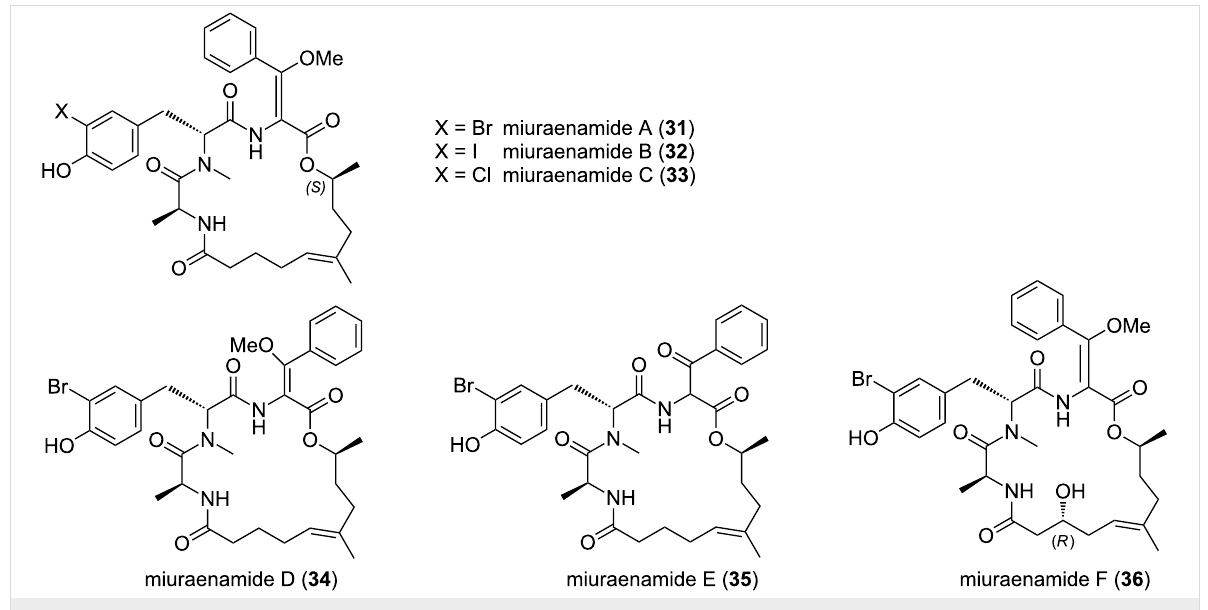
Figure 13: Structures of miuraenamides A–F from P. miuraensis .